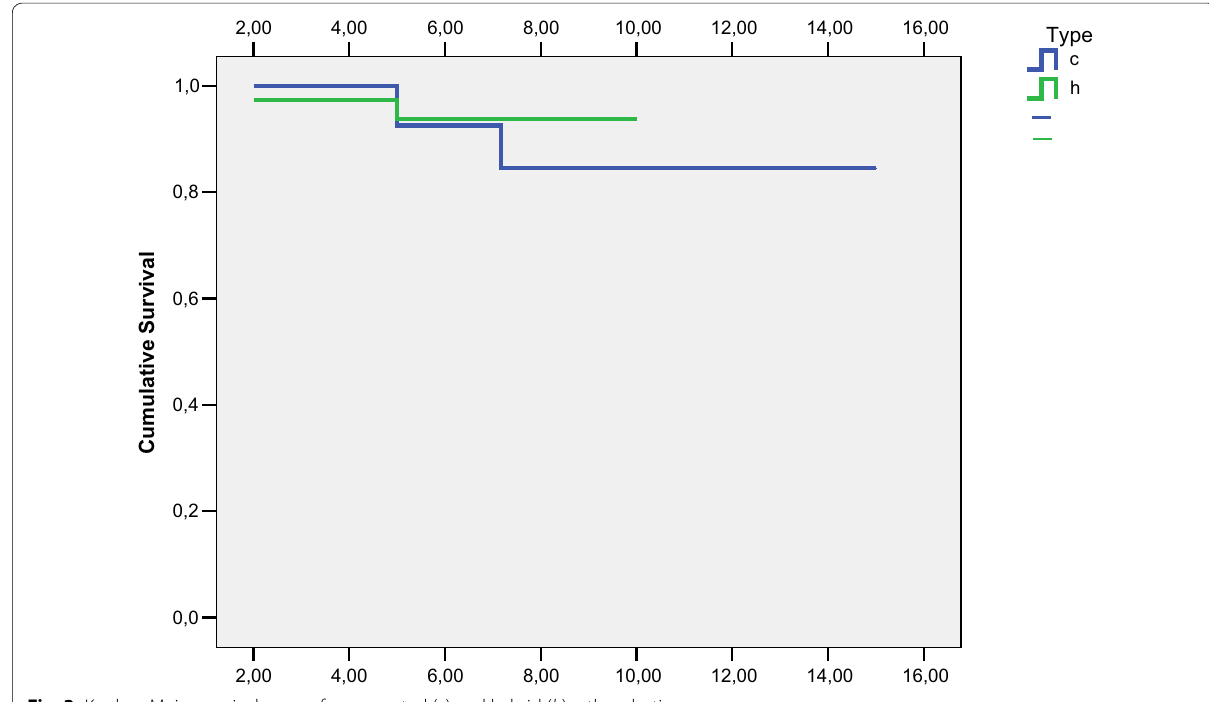
Fig. 3 Kaplan–Meier survival curves for cemented ( c ) and hybrid ( h )